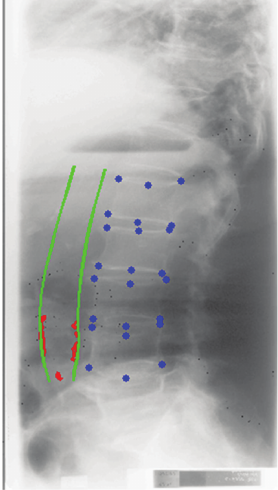
Figure 1: A manual annotation of an X-ray: in blue we see distinct vertebra points, in green the aorta wall, and in red the